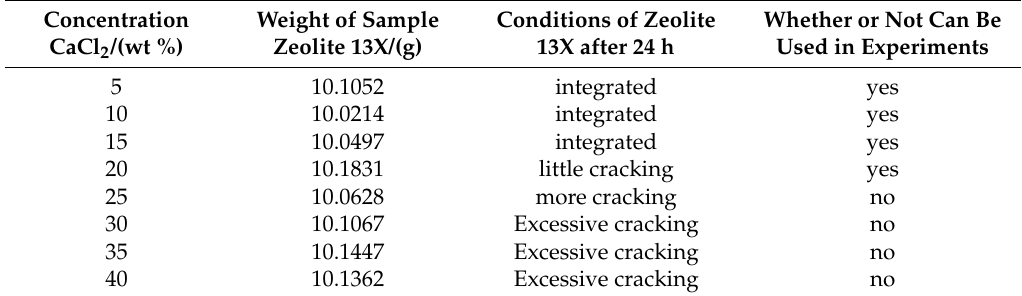
Table 3. Conditions of preparing13X/CaCl 2 composite adsorbent.